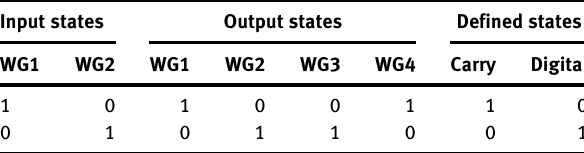
Table  : Encoding scheme of all-optical half binary